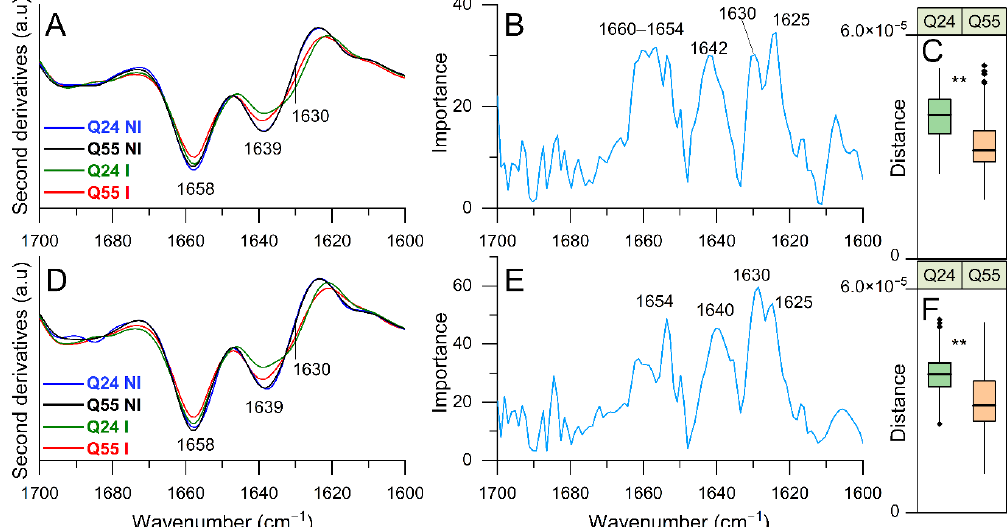
Figure 4. FTIR analysis of protein secondary structure modifications investigated in the 1700–1600 cm − 1 spectral range. The second derivatives of representative FTIR spectra - identified by PLS-DA—of E. coli cells expressing ATX3-Q24 and ATX3-Q55 at 5 ( A ) and 8 ( D ) hours of induction, and of NI cells are reported. In ( B ) (5 h) and ( E ) (8 h), the loading plots representing the spectral components more relevant for the discrimination between the classes are displayed. In ( C ) (5 h) and ( F ) (8 h), the distribution of distances between I and NI is represented as box plots, where the horizontal line within the box is the median. The box ends show the first (Q1) and third quartiles (Q3), the upper whisker is the minimum between the absolute maximum and Q3 + 1.5* interquartile range (IQR), and the lower whisker is computed as the maximum value between the absolute minimum and Q1 − 1.5*IQR. Here, IQR is the interquartile range computed as Q3 – Q1. Values beyond whiskers (outliers) are shown as dots. The distances are computed as following: the Euclidean distance between the PLS-DA scores was computed for each combination of samples within the two groups I and NI, obtaining an ensemble of distances for ATX3-Q24 and ATX3-Q55 independently. The horizontal bar above the two box plots shows the significance of the difference between the ATX3-Q24 and ATX3-Q55 distance distribution. The significance is computed using an unpaired two-sample T-test. **: p -value < 0.01. The reported spectroscopic analyses were performed on spectra from three independent experiments, where 5–7 spectra were collected for each condition in each experiment.